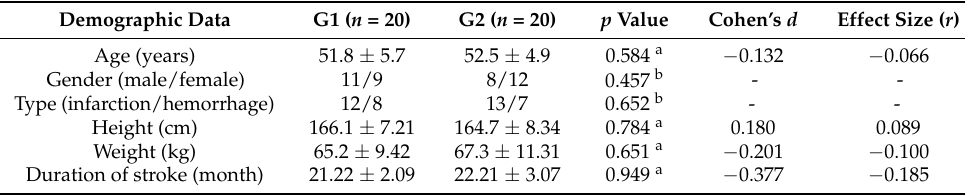
Table 1. Demographic and baseline clinical characteristics in both groups, pretreatment.